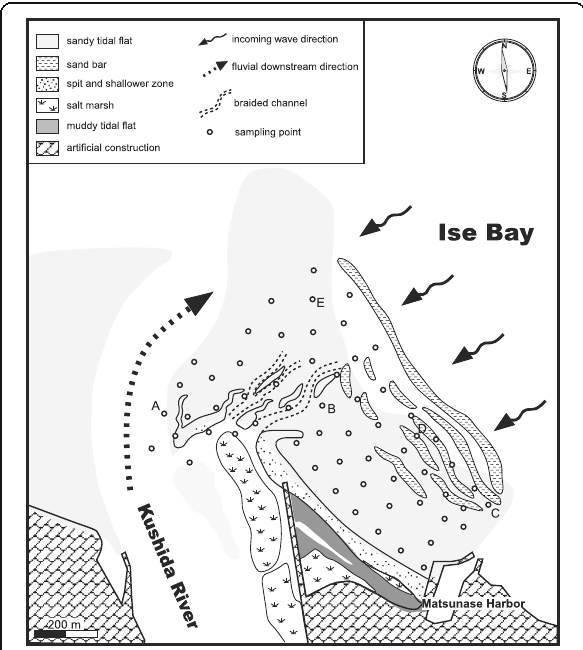
Fig. 2 Geomorphology of the study area and sampling localities for GSTA methods. Geomorphology is after fluvial flooding in July